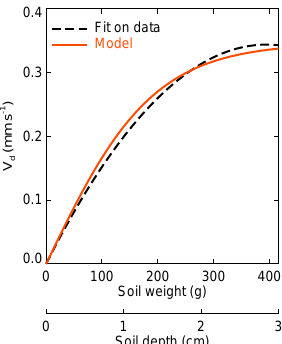
Figure 5. Modelled (solid line) and observed (dotted line) response of the modelled OCS deposition velocity ( V d ) to soil column depth. Soil column depth is also converted into soil weight assuming a soil surface area of 165.1cm 2 and a soil bulk density and pH of 0.85kgm 3 and 7.2 respectively, to be comparable with the exper- imental setup used in Kesselmeier et al. (1999) to derive the ob- served response curve. Model results shown here were obtained us- ing the diffusivity model of Moldrup et al. (2003) and assuming an enhancement factor and an optimum temperature for OCS hydroly- sis of 26000 and 25 ◦ C respectively and no source term. Soil water content and temperature were also set to 11% weight and 17 ◦ C re- spectively, to be comparable with the experimental data, while the fit on observed uptake rates that was originally reported were con- verted into deposition velocities assuming a constant mixing ratio of 600ppt (Kesselmeier et al., 1999).